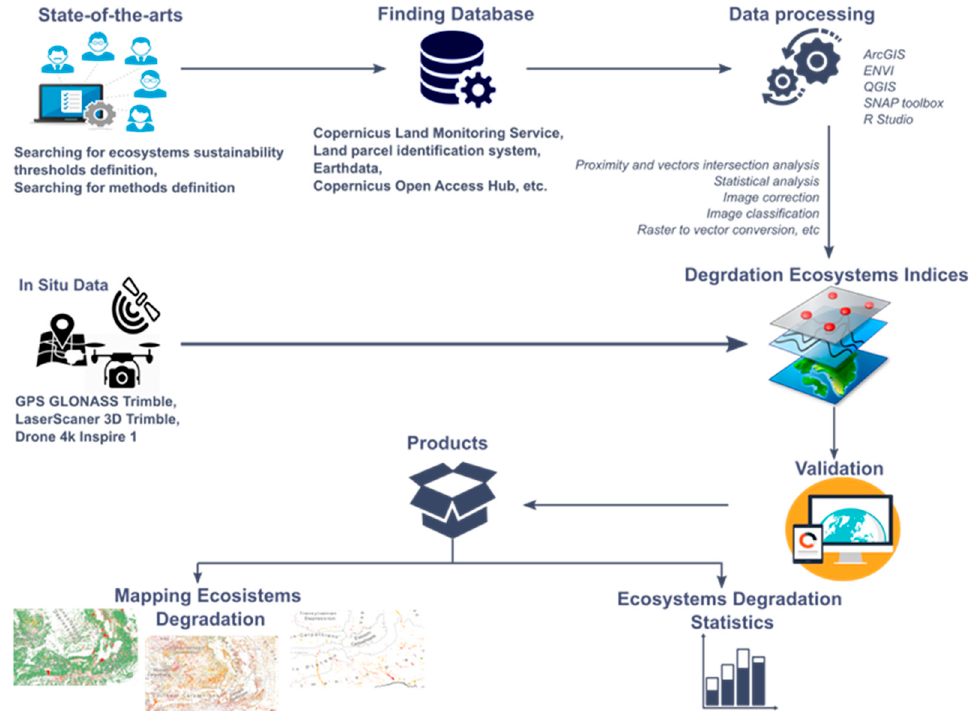
Figure 2. Methodological flow in order to assess the state of ecosystem degradation.